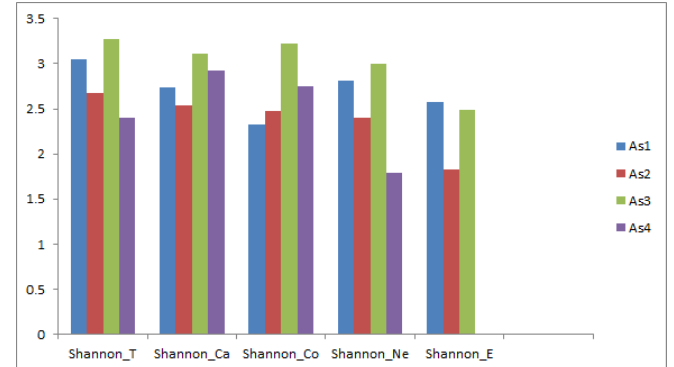
Figure 5. Shannon diversity values (T, Ca, Co, Ne, E) (Shannon_T = total diversity; Shannon_Ca = characteristic community species diversity; Shannon_Co = companion community species diversity; Shannon_Ne = non-endemic species diversity; Shannon_E = endemic species diversity). As1: Hyeronimo montanae - Magnolietum pallescentis . As2: Cyatheo furfuracei - Prestoetum motanae . As3: Hyeronimo dominguensis - Magnolietum hamorii . As4: Ormosio krugii - Prestoetum montanae.